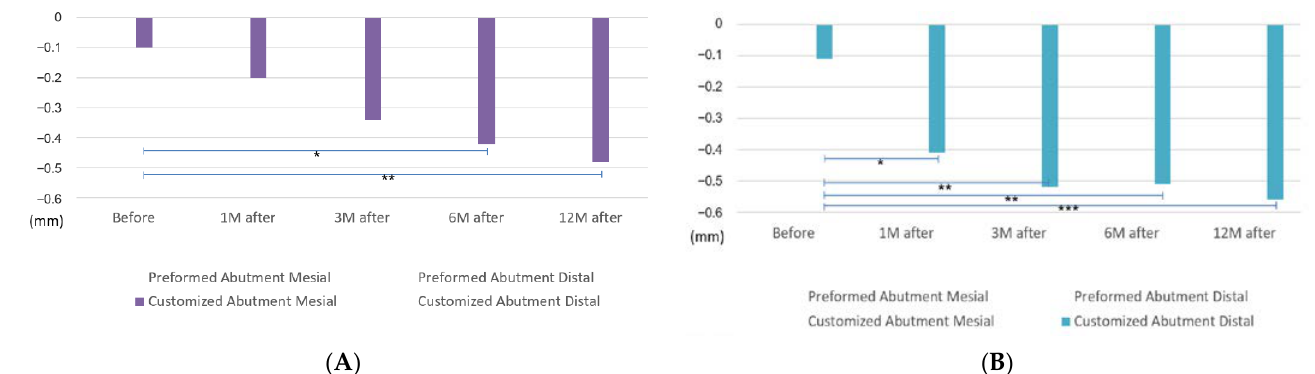
Figure 5. Comparison of the mesial ( A ) and distal ( B ) marginal bone levels in the CAs. CA, custom- ized abutment. (* p < 0.05, ** p < 0.01, *** p < 0.001, by two-tailed t -test.)